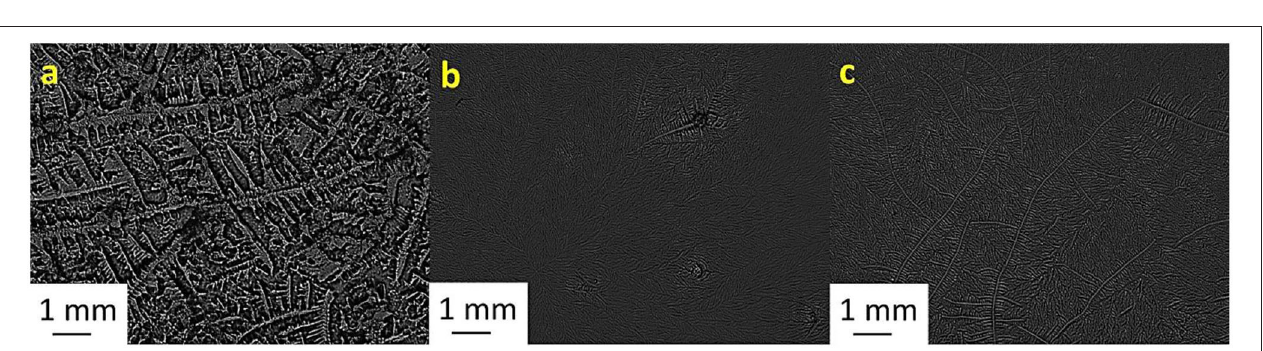
FIGURE 4 | Tear ferning patterns of (a) S4, (b) S4:NaCl (1:1), and (c) S4:KCl (1:8). S4, fourth sheep tear sample.